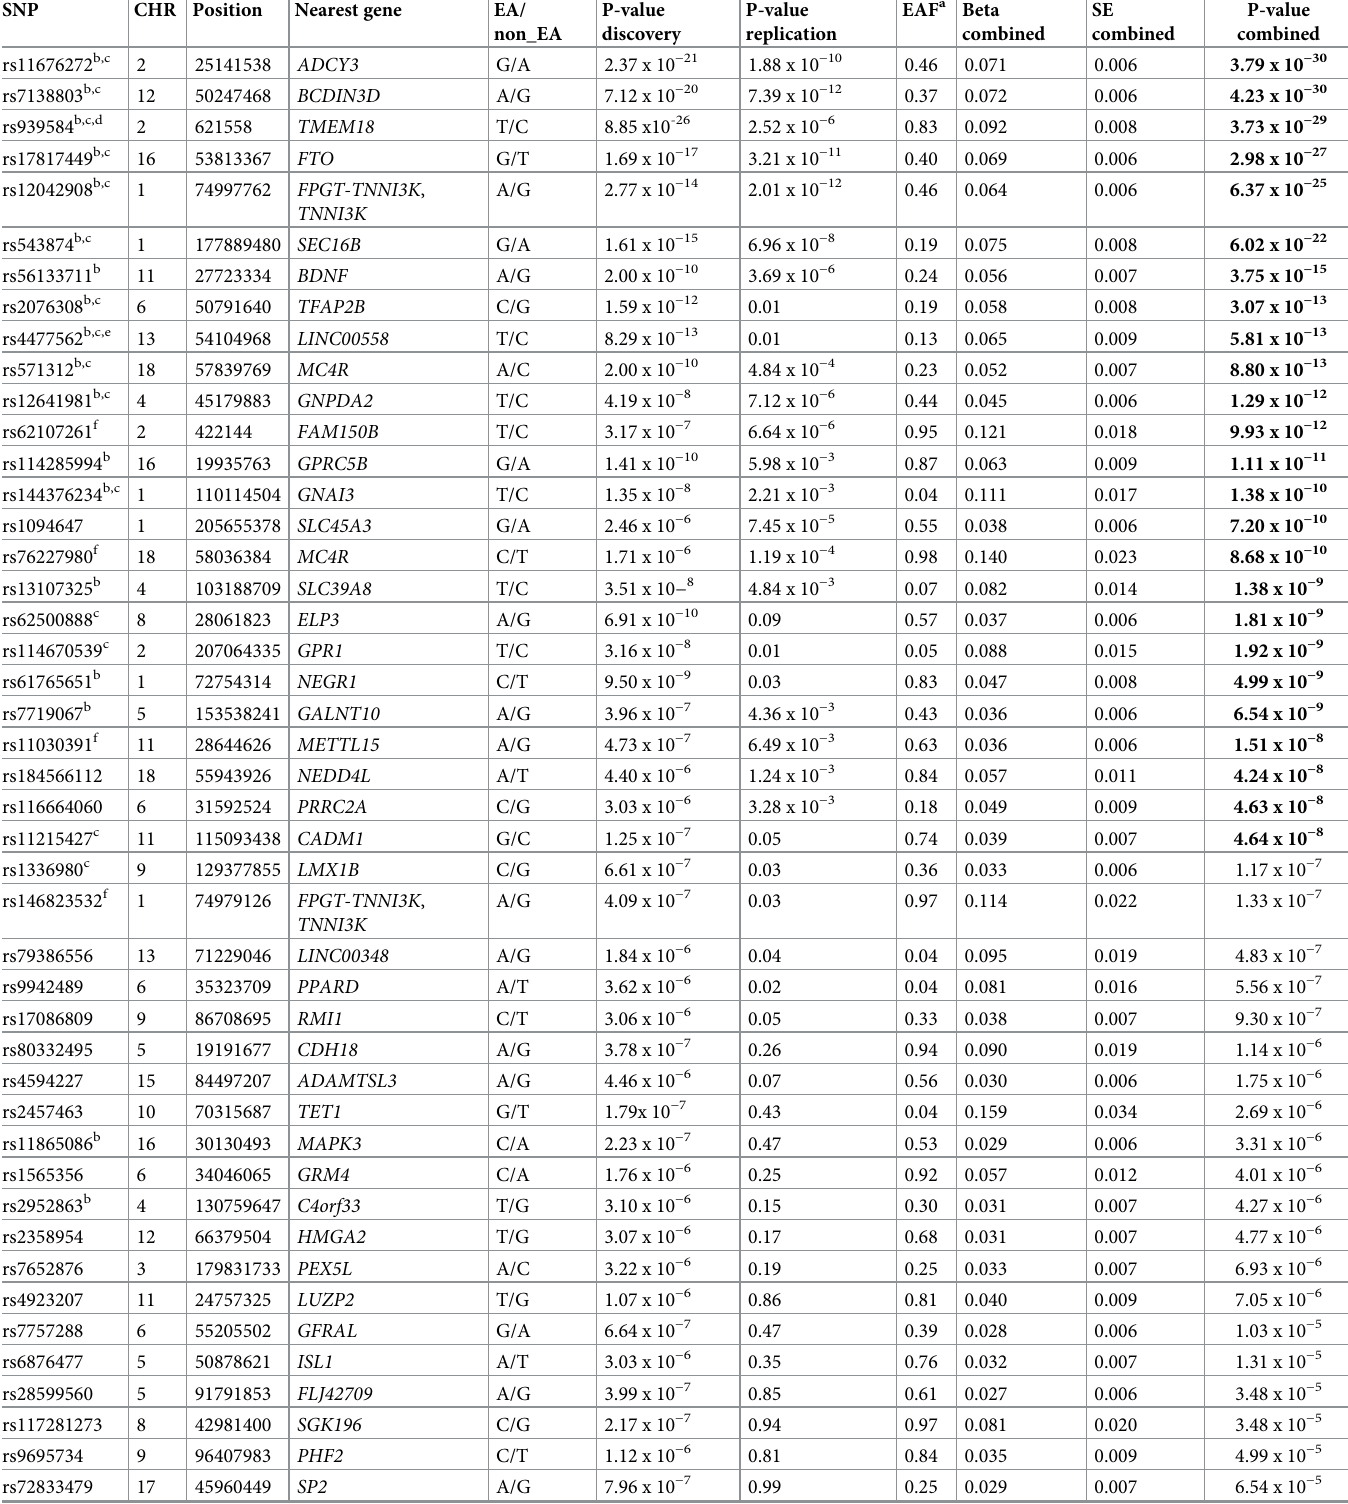
Table 1. Results of the discovery, replication and combined analyses for the 47 loci with P-values < 5 x 10 − 6 in the discovery